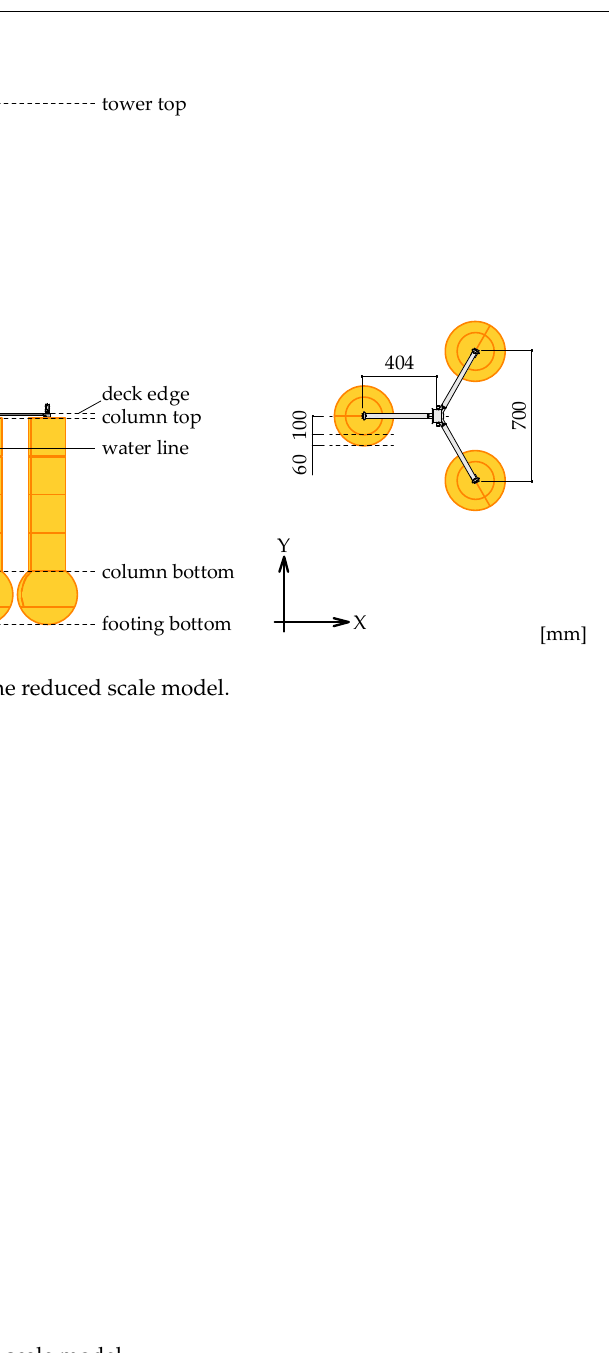
Figure 2. Main dimensions of the reduced scale model. Figure 2. Picture of the reduced scale model. Table 1. Scale factors using Froude